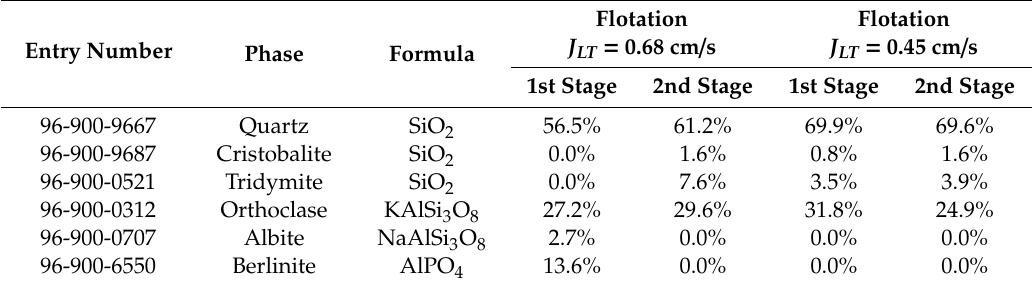
Table 2. Present phases and their percentage in weight, obtained in the two stages of batch flotation, at values of J LT = 0.68 and 0.45 cm / s, respectively. The phases were obtained by means of